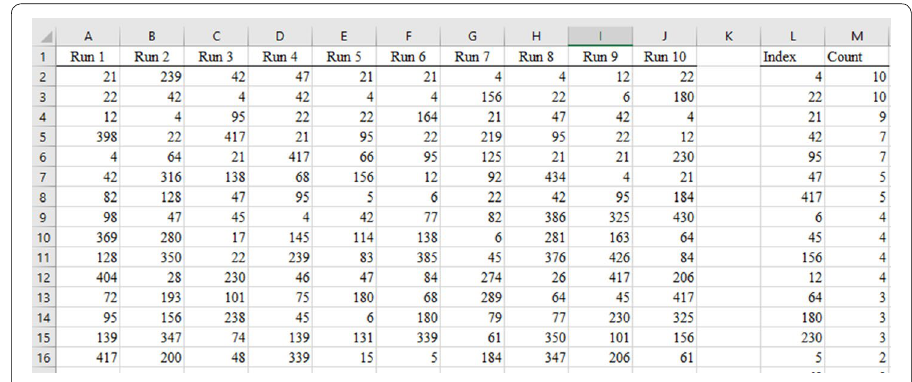
Fig. 11 Highest-ranked FIS output for 10 runs, 10,000 subsets per run